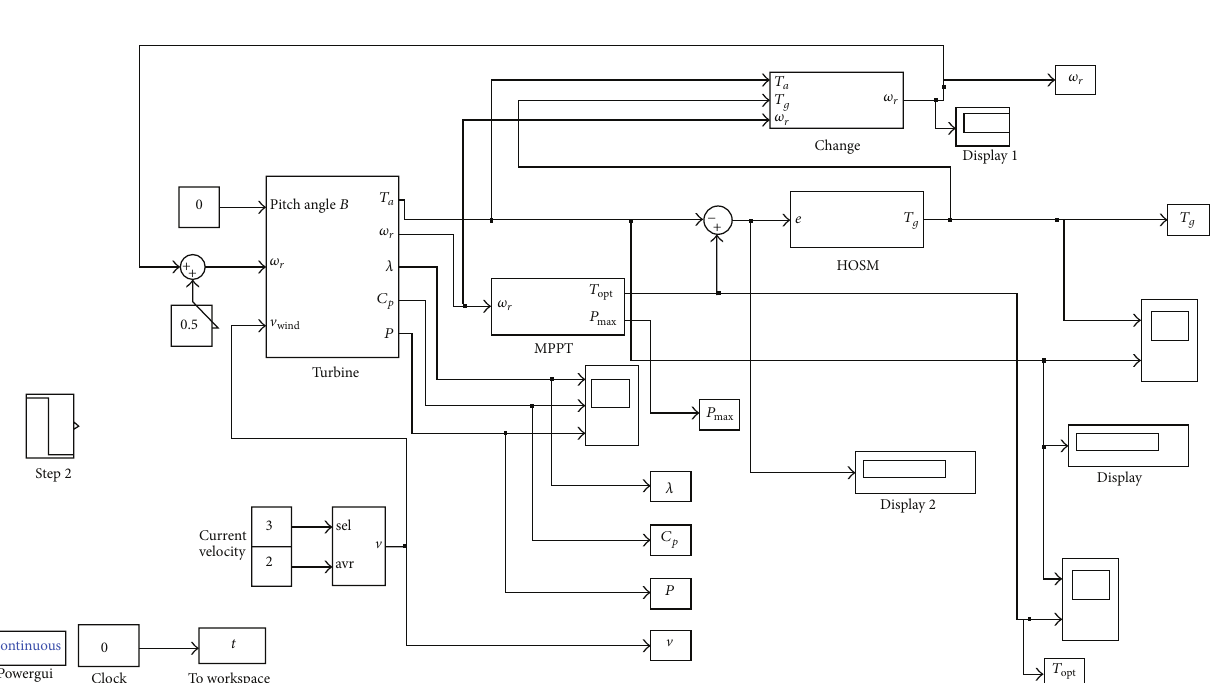
Figure 11: The Simulink model of the